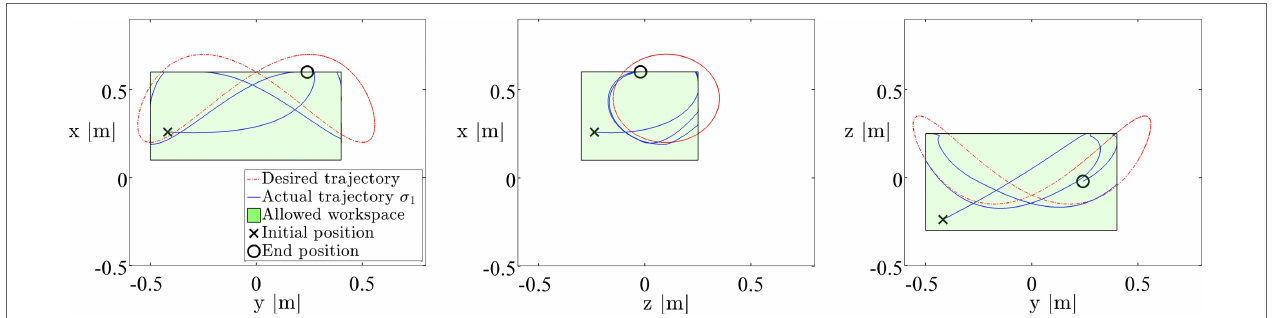
FIGURE 7 | Actual vs. desired end effector trajectory from example 1 plotted in the xy -, xz - , and yz -plane, respectively . A three-dimensional plot is given in Figure 6A